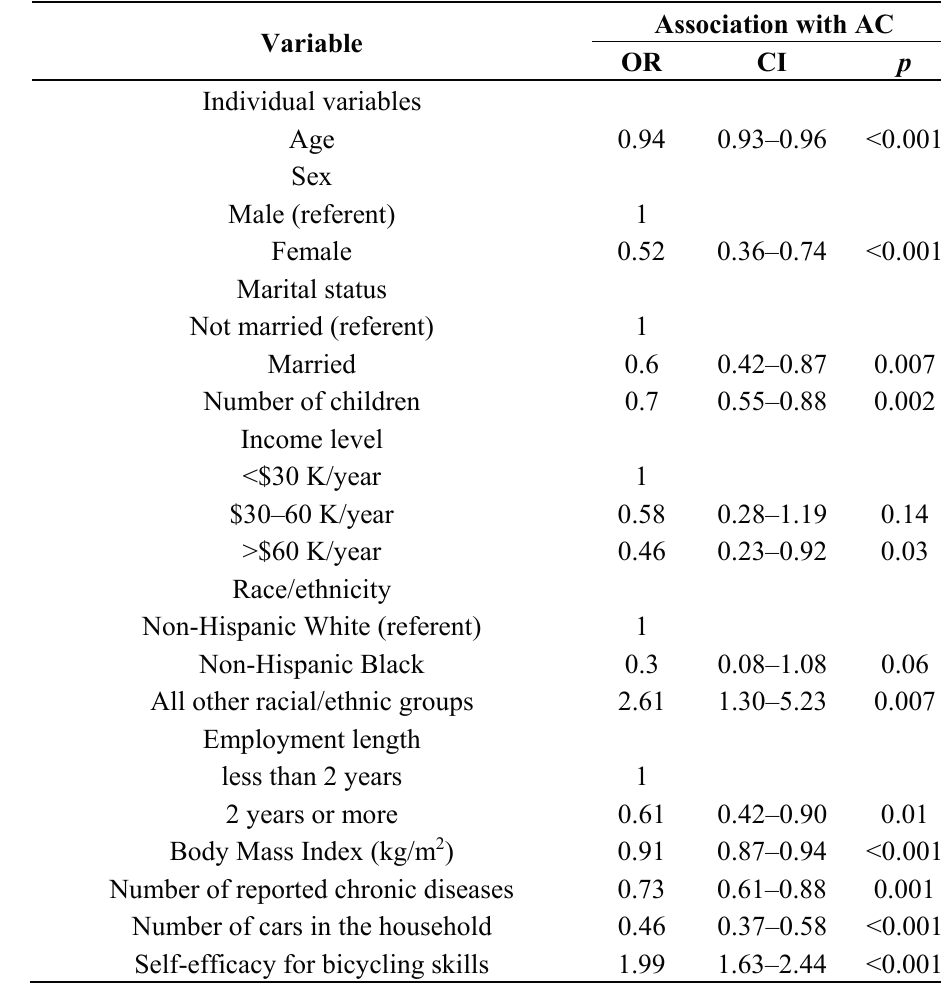
Table 2. Odd ratios for being an Active Commuter, Controlling for Public Transit Use ( n =